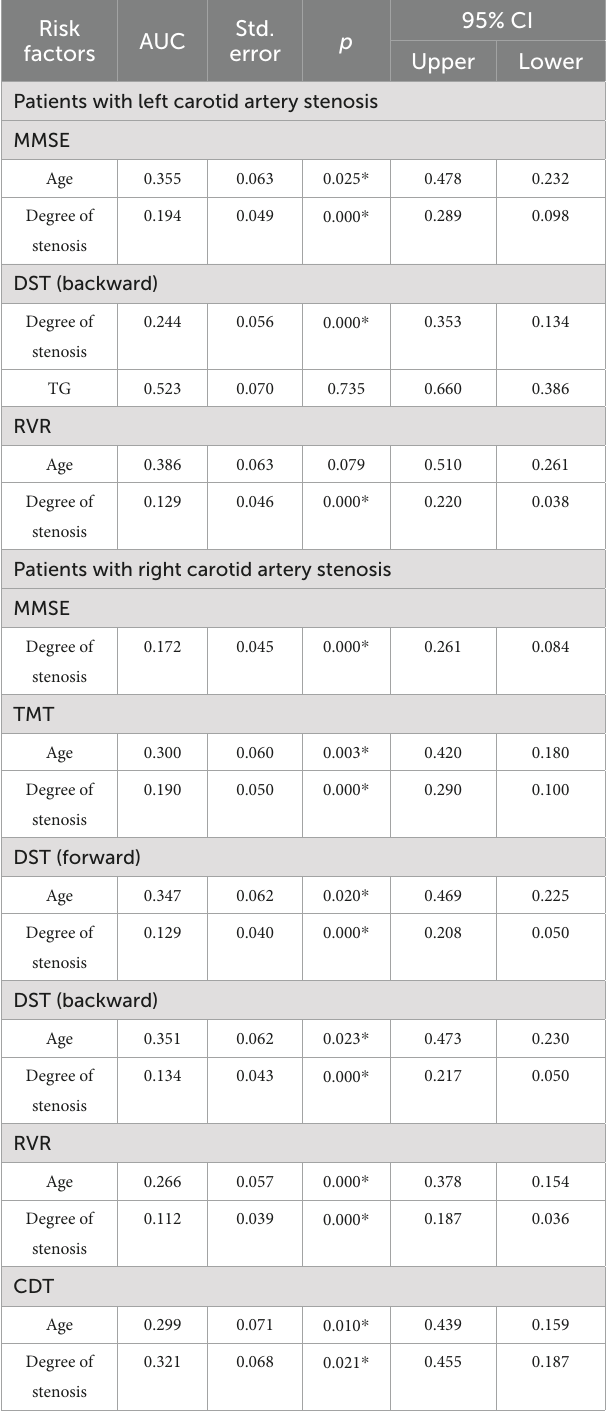
TABLE 7 The receiver operating characteristic curve performed for independent risk factors of cognitive impairment in patients with carotid artery